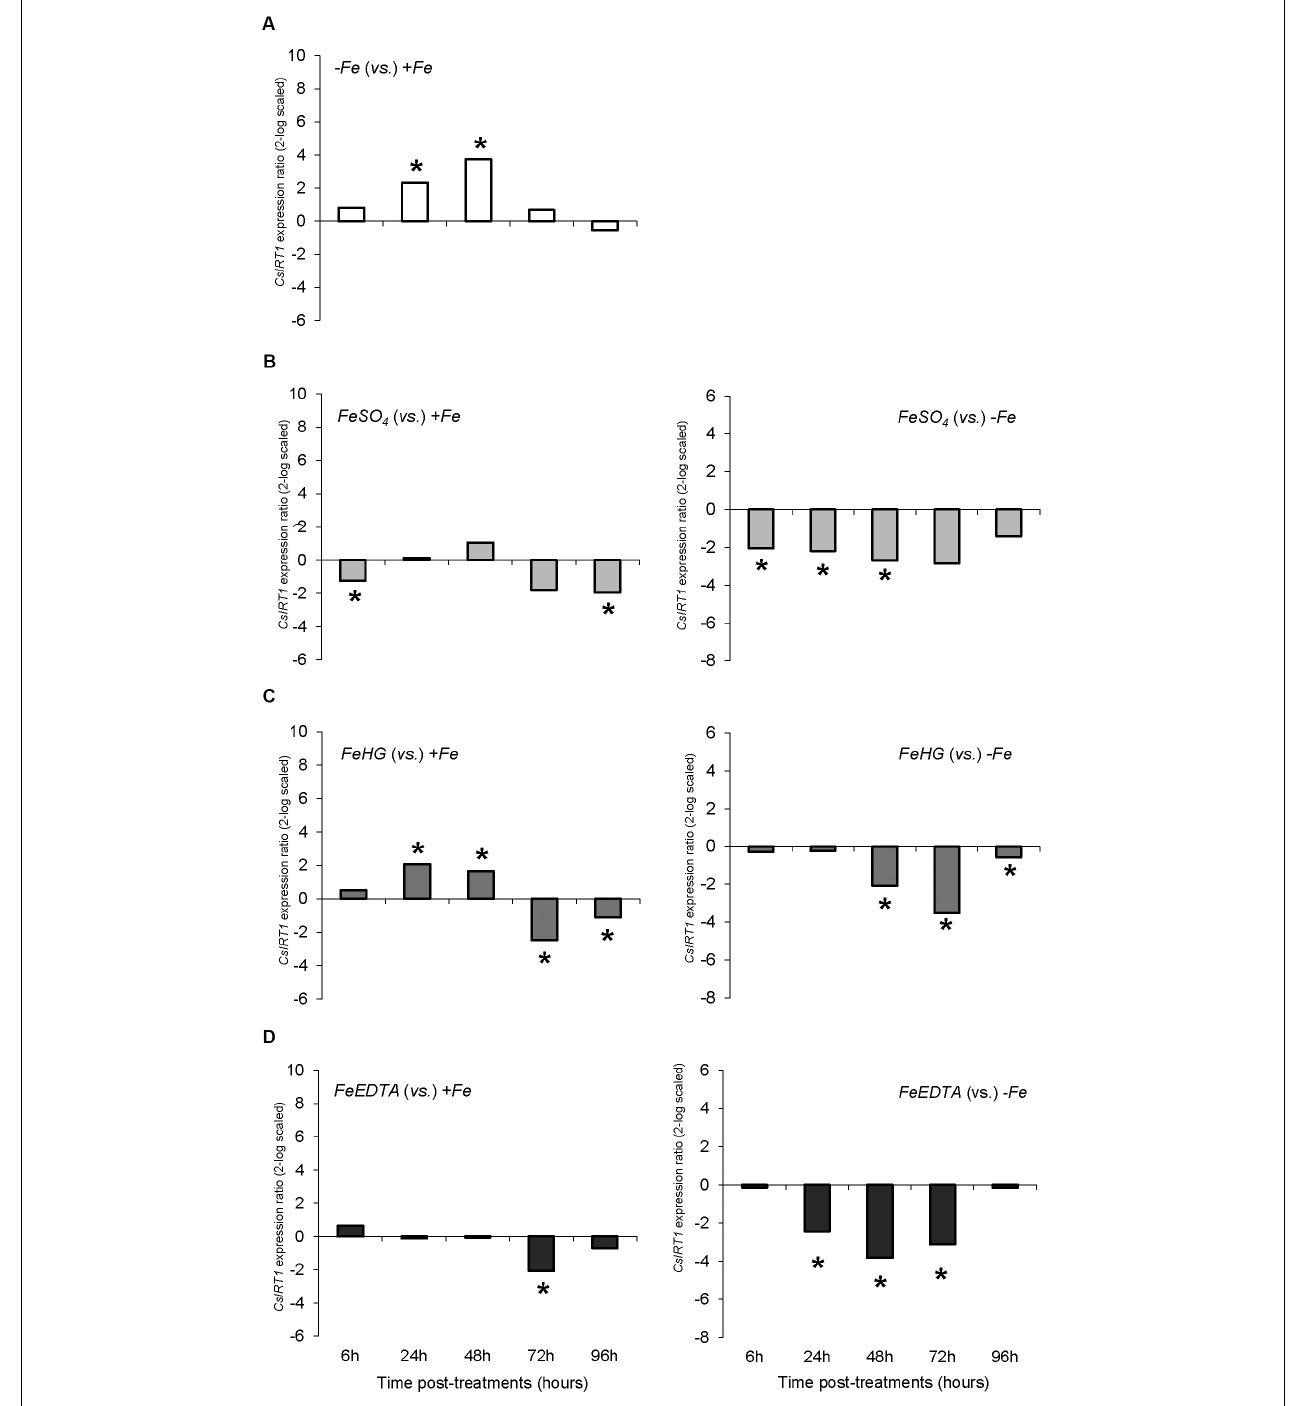
FIGURE 7 | CsIRT1 expression results in cucumber roots from Experiment II. Plants were grown in a nutrient solution with 5 µ M Fe, and then some of them were transferred to nutrient solutions with 40 µ M Fe (+ Fe ). The rest were transferred to nutrient solutions without Fe (– Fe ). A fourth of the – Fe plants received no further treatments in order to function as a deficient control. The rest of the plants received a total amount of 2.54 mg Fe/plant (divided into a 3-day application) of one of the following treatments: FeSO 4 , 3 mM FeSO 4 ; Fe-HG , 3 mM Fe(III)-heptagluconate; Fe-EDTA , 3 mM Fe(III)-EDTA. (A) Expression of CsIRT1 in root of – Fe plants versus + Fe plants. (B) Expression of CsIRT1 in root of FeSO 4 plants versus + Fe (left) and – Fe (right) plants. (C) Expression of CsIRT1 in root of Fe-HG plants versus + Fe (left) and – Fe (right) plants. (D) Expression of CsIRT1 in root of Fe-EDTA plants versus + Fe (left) and – Fe (right) plants. Data are means ± SE ( n = 5). Asterisks indicate significant differences between treatments at P < 0.05 based on one-way ANOVA and Fisher’s post hoc test. Statistical analysis of relative gene expression results was assessed using P-pairwise fixed reallocation randomization